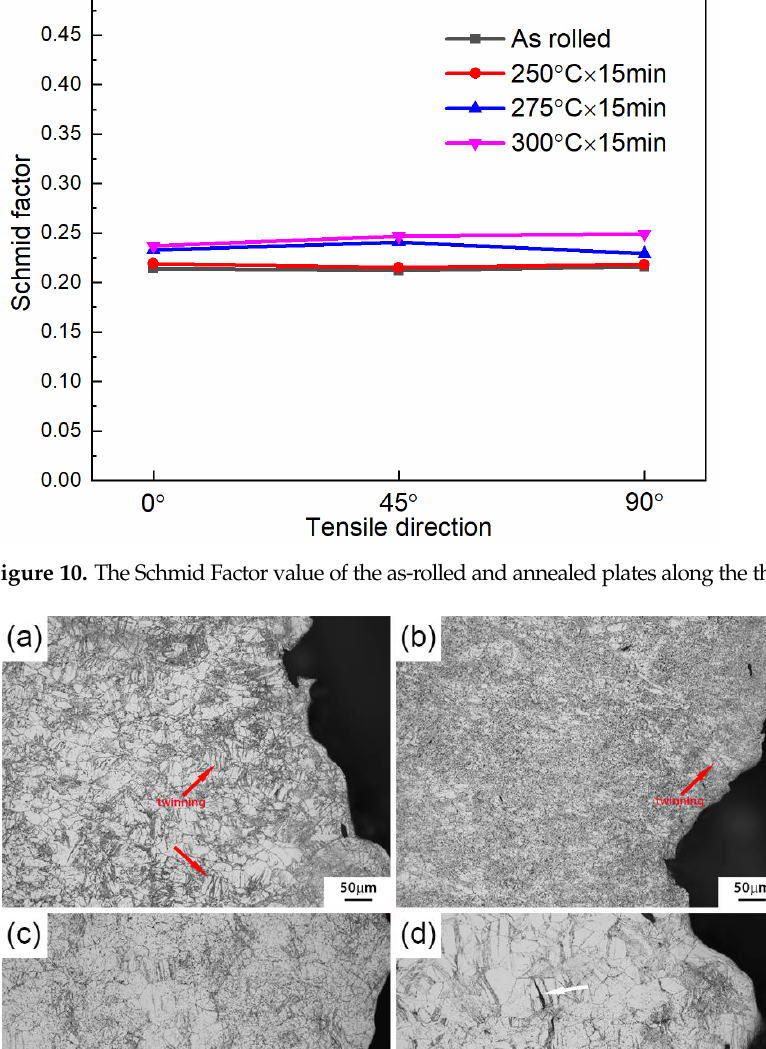
Figure 11. Fracture surfaces of the plates: ( a ) as-rolled, annealed at ( b ) 250 °C, ( c ) 275 °C, and ( d ) 300 °C for a fixed time of 15 min. The red arrows indicate twinned grains. The white arrows indicate the micro-cracks along the twin boundaries.